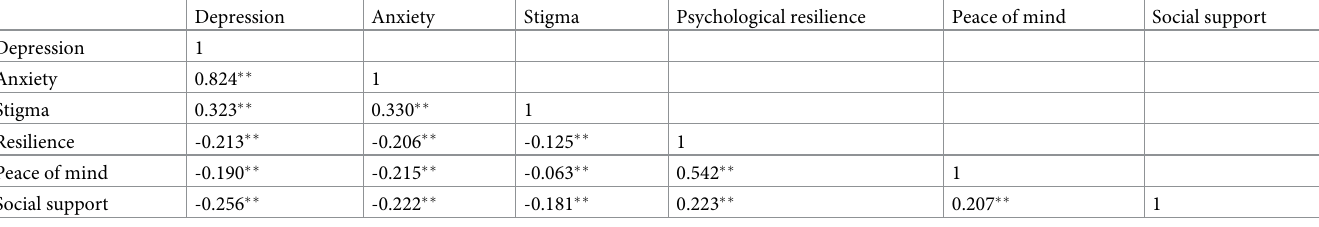
Table 3. Correlation matrix of mental health status in enrolled COVID-19 survivors with Pearson correlation